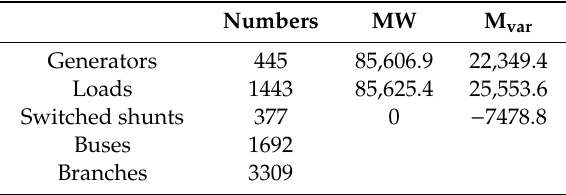
Table 1. Korean electric power system information used in this study.